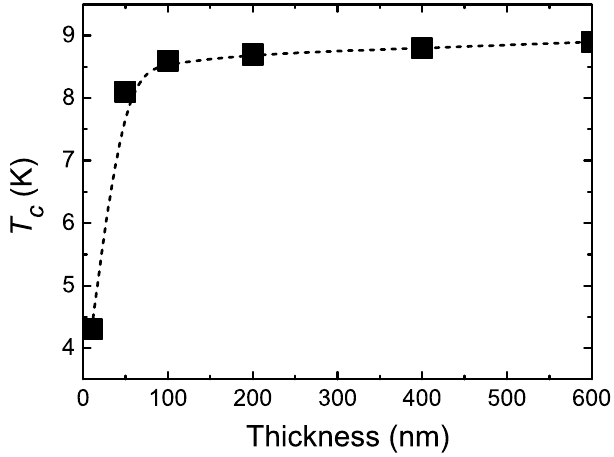
Figure 4. Film thickness dependence of T c of the NbTi alloy thin film. The T c is defined as the endpoint temperature of decrease in resistivity due to superconducting transition in the resistivity curve as a function of temperature. The T c increased with thickness, and especially increased sharply from 10 nm to 50